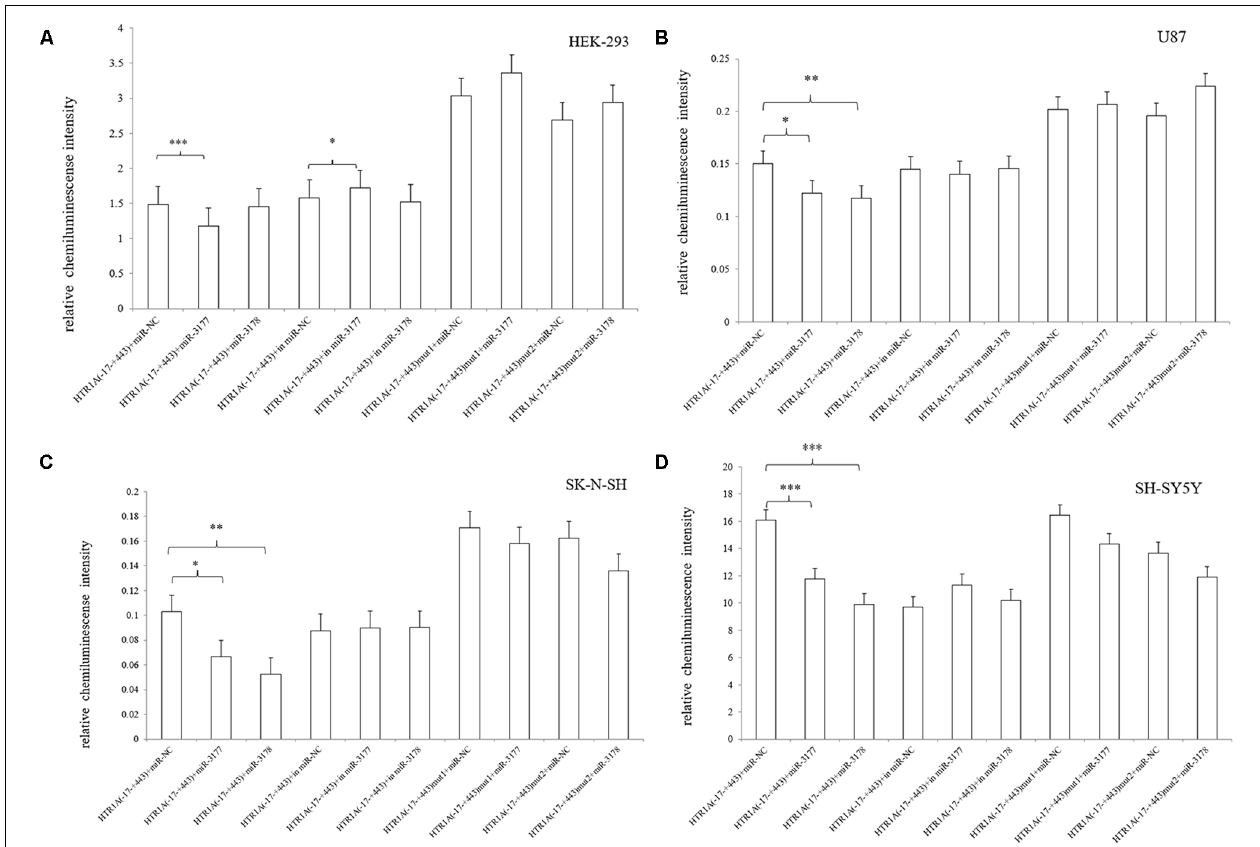
FIGURE 5 | Effects of hsa-miR-3177-5p and hsa-miR-3178 on HTR1A gene expression (A–D) . The relative chemiluminescence intensity of the pmirGLO-HTR1A ( − 17–+443) + hsa-miR-3177-5p mimic was lower than that of the pmirGLO-HTR1A ( − 17–+443) + miRNA NC mimic in the HEK-293, U87, SK-N-SH and SH-SY5Y cells. However, hsa-miR-3178 inhibited protein expression of the − 17 bp to +443 bp sequence only in the U87, SK-N-SH and SH-SY5Y nervous system cell lines. Importantly, when the miRNAs recognition sites were deleted, inhibition by hsa-miR-3177-5p and hsa-miR-3178 disappeared. ∗ 0.02 ≤ p < 0.05, ∗∗ 0.001 ≤ p < 0.02, ∗∗∗ p <